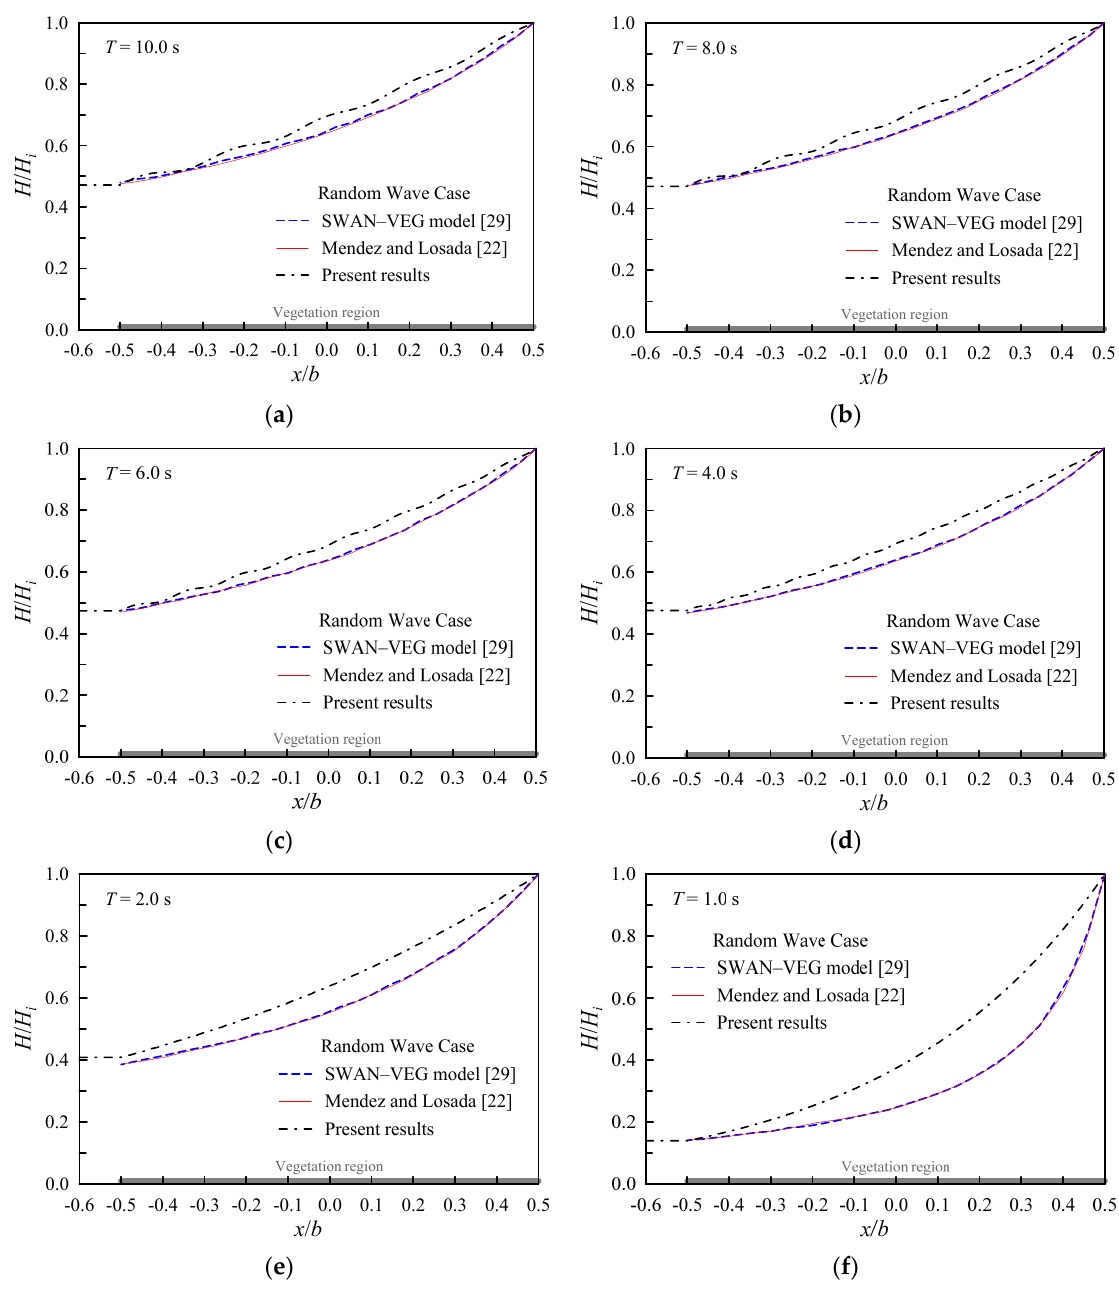
HH evolution in the vegetation region for the present analytical Figure 2. Comparison of Figure 2. Comparison of H / H i evolution in the vegetation region for the present analytical solution, i SWAN–VEG numerical model [29], and random wave transformation model of Mendez and Losada [22] solution, SWAN–VEG numerical model [29], and random wave transformation model of Mendez H 0.4 m, = d 2 m, = b 100 m, = b 0.04 m, = N 10 steams/m 2 , = C 1, and Losada [22] ( = ( H i = 0.4 m, d = 2 m, b = 100 m, b v = 0.04 m, N v = 10 steams / m 2 , C D = 1, S = 1, µ = 0.333, v v D i ρ 681.43 kg/m 3 , = ρ 1000 kg/m 3 , =ν 1.12 × -6 10 m 2 /s, =β = S 1, =μ 0.333, = ' n 0.999, = n (cid:48) = 0.999, ρ s = 681.43 kg / m 3 , ρ w = 1000 kg / m 3 , ν = 1.12 × 10 − 6 m 2 / s, β = 4.35 × 10 − 10 m 2 / N, s w and G = 1.29 × 10 5 N / m 2 ). ( a ) T = 10 s; ( b ) T = 8 s; ( c ) T = 6 s; ( d ) T = 4 s; ( e ) T = 2 s; ( f ) T = 1